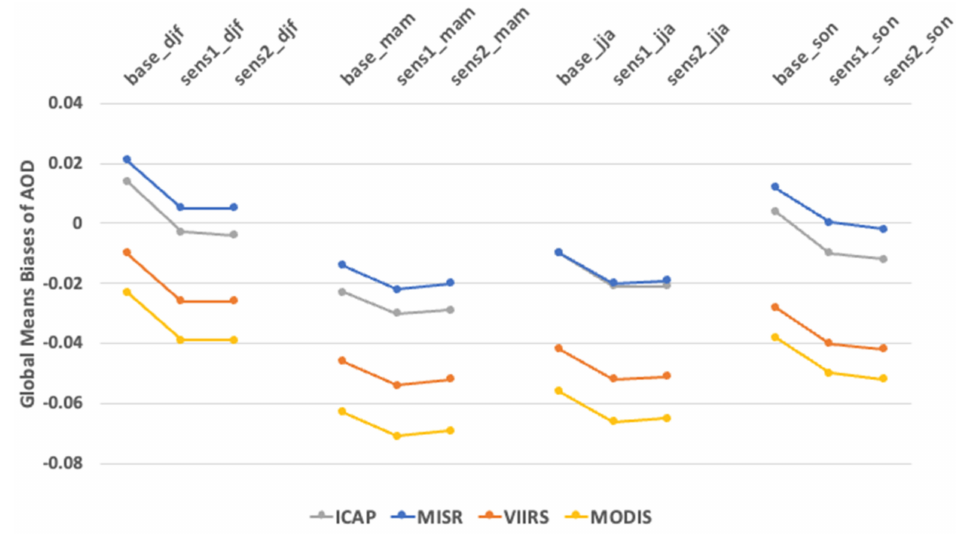
Figure 8. Comparisons of global seasonal means of the differences in GEFS AOD ( BASE1, SENS1 and SENS2 ) from ensemble simulation of ICAP and satellite observations of MISR, VIIRS, and